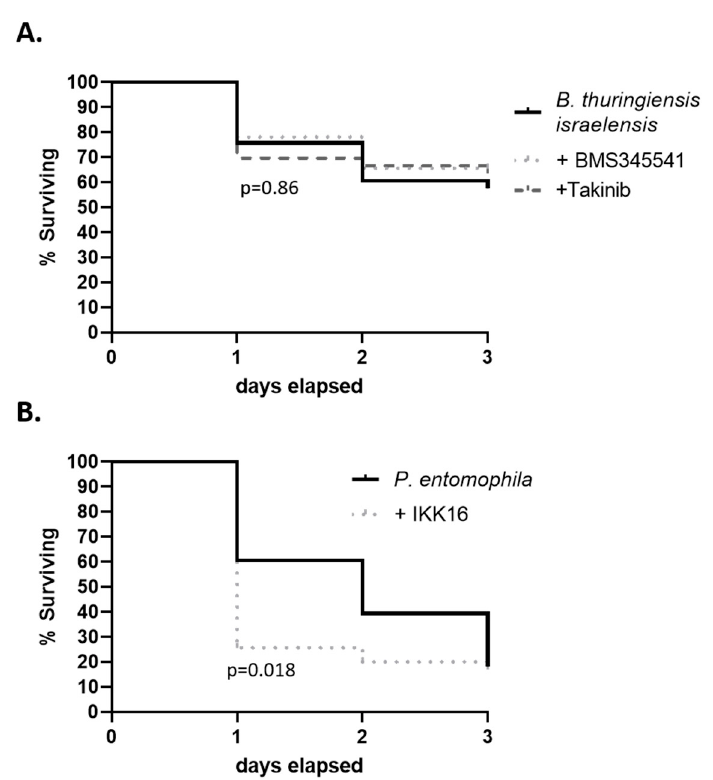
Figure 5. Three-day survivorship of bed bugs fed combinations of NF-KB signaling inhibitors and entomopathogenic bacteria. Inhibitors at a final concentration of 10 μ g/mL were combined in a blood meal with ( A ) Bacillus thuringiensis israelensis or ( B ) Pseudomonas entomophila. Shown is the cumulative survival from 3 independent biological replicates of 10–14 adult insects per group.